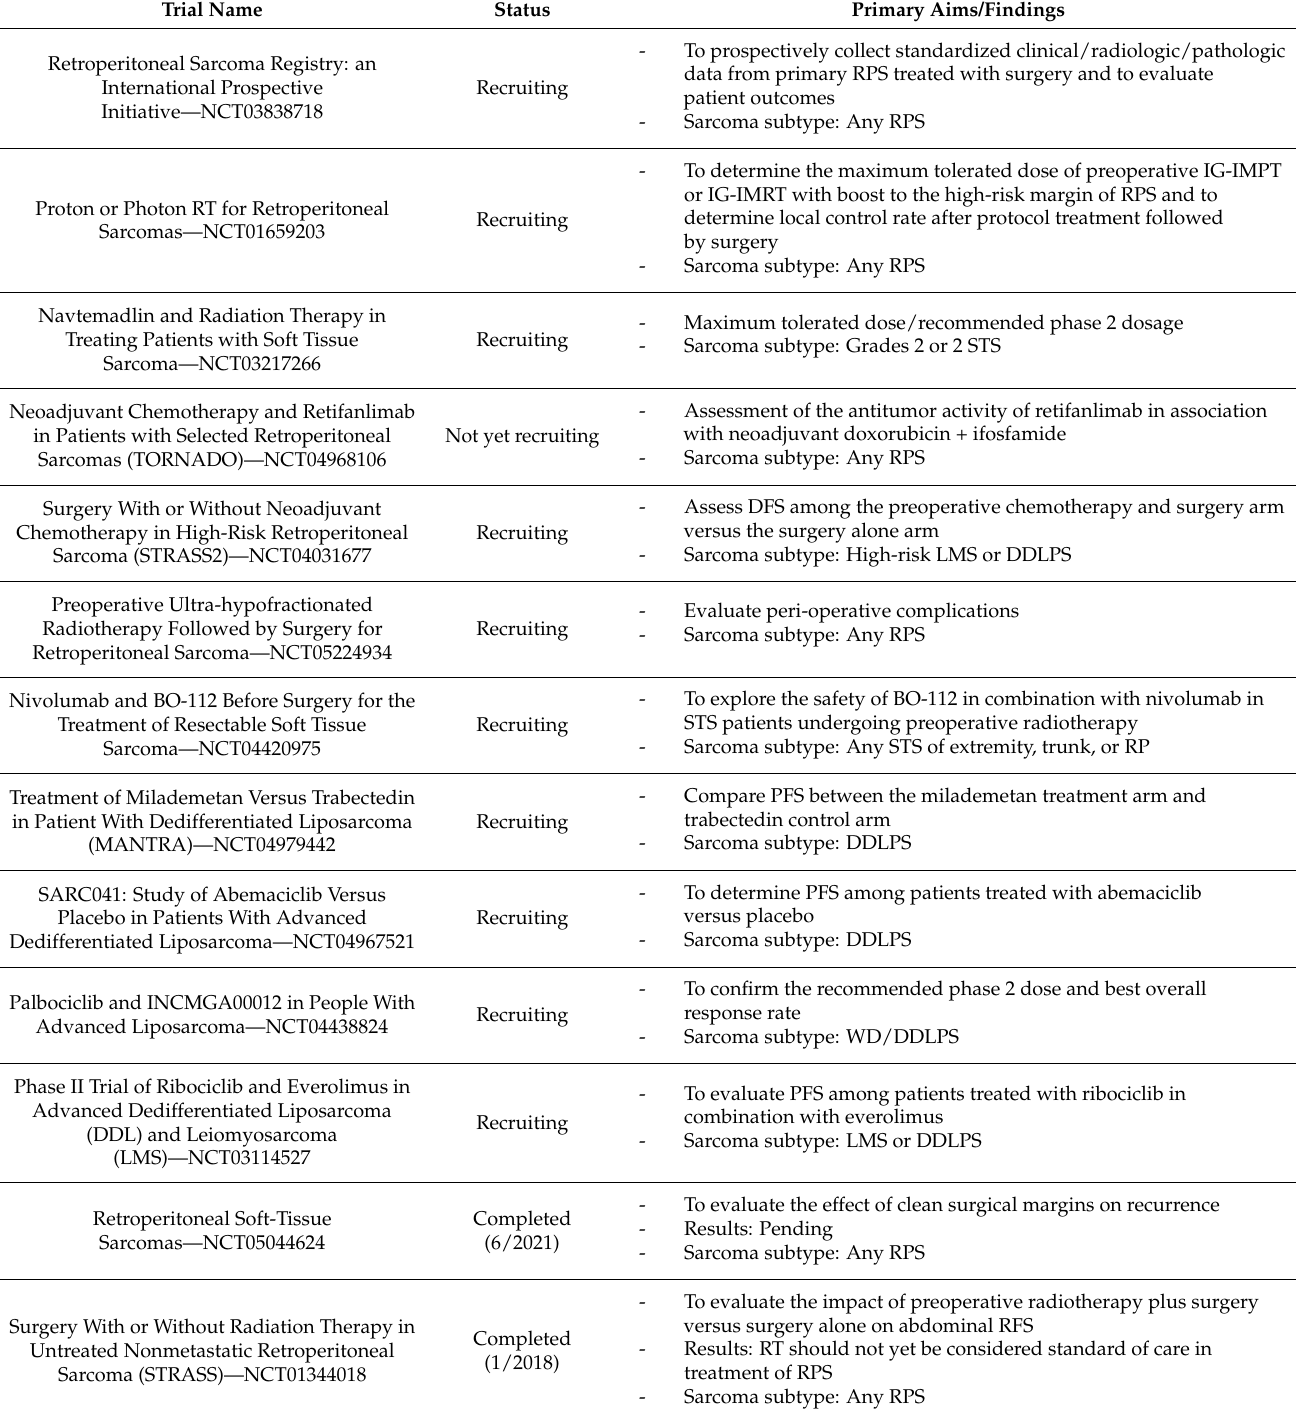
Table 1. Recent and ongoing trials in retroperitoneal